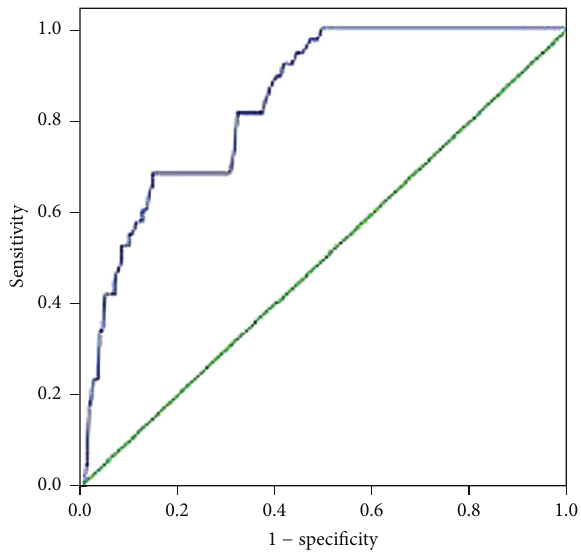
Figure 2: In a receiver operative characteristic (ROC) curve analysis, the area under the curve (AUC) of miRNA-21 levels during surgery for PPCs was 0.838 (95% CI, 0.782–0.894; 𝑃 < 0.05 ). At a cutoff value of 1.745, miRNA-21 had a sensitivity of 68.4% and a specificity of 70.6% for predicting PPCs within 7 days after